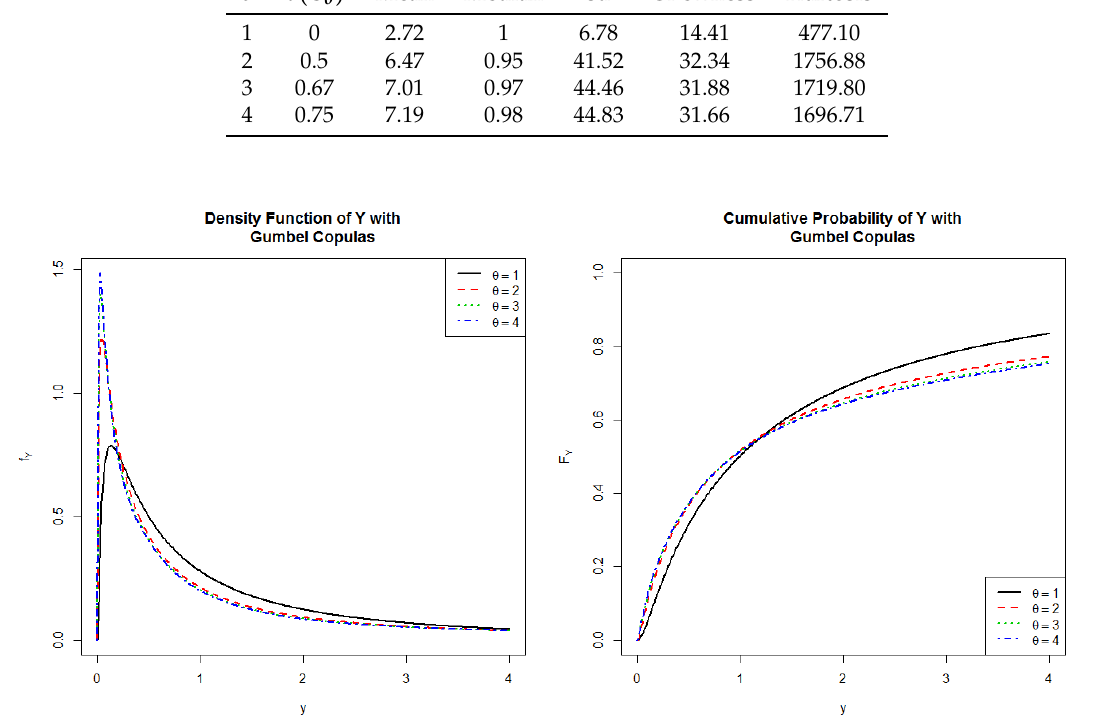
Figure 4. PDFs and CDFs of the product of two log-normal distributed random variables having Gumbel